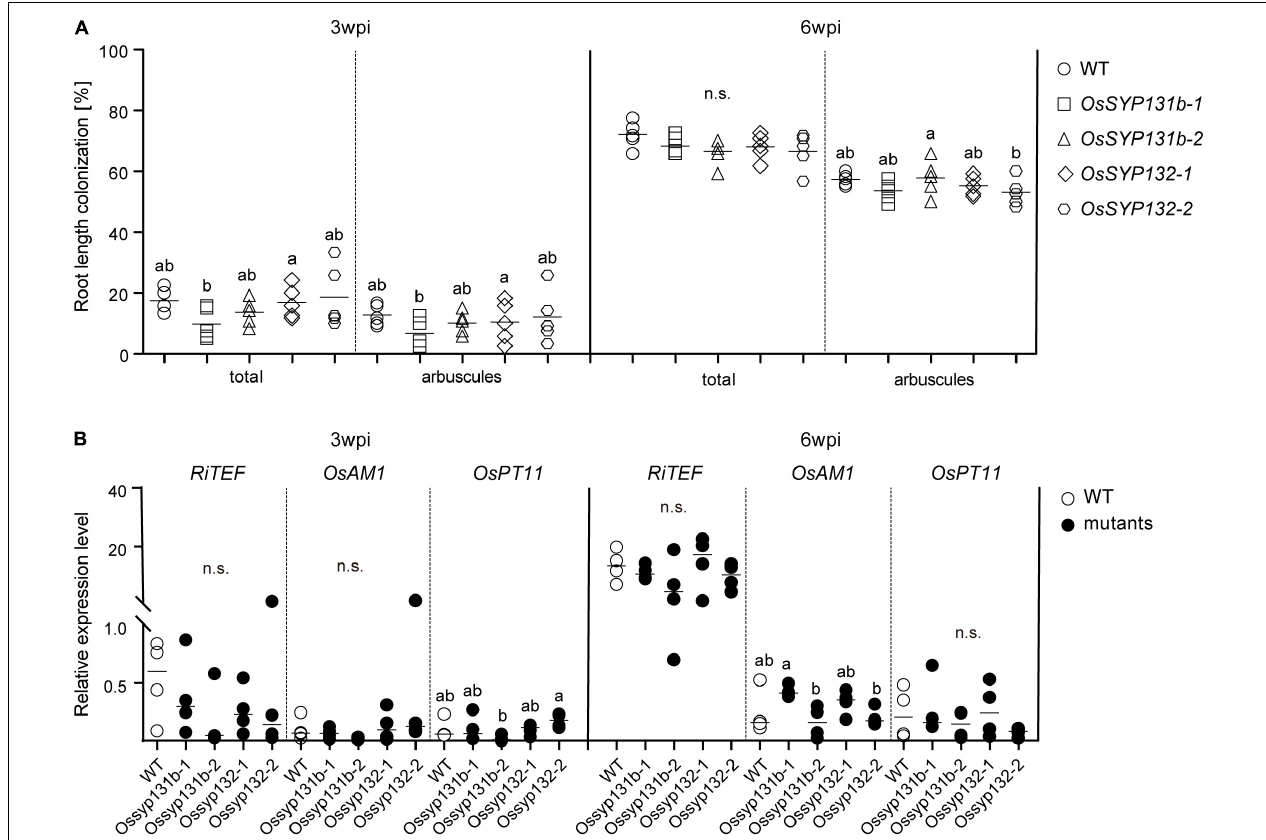
FIGURE 4 | AM symbiosis was normal in the Ossyp131b and Ossyp132 single mutants. (A) The total root length colonization rates and arbuscule abundance (%) of WT rice and Ossyp131b , Ossyp132 mutants at 3- and 6-wpi by R. irregularis were determined by the gridline intersect method. Data were individual values from five biological replicates and the horizontal line showed the mean value. Different letters indicate statistical differences between genotypes evaluated by the Tukey’s honest significance test (all pairs between WT and mutants, P > 0.05, n.s., no significance). (B) Transcript accumulation of OsRiTEF ( Translation Elongation Factor ), OsAM1 and OsPT11 ( Phosphate transporter 11 ) were measured by qRT-PCR in WT roots and mutants in the presence of R. irregularis at 3- and 6-wpi. The housekeeping gene, OsUBI1 , was used for normalization. Data were individual values from four biological replicates and the horizontal line showed the mean value. Different letters indicate statistical differences evaluated by the Tukey’s test, too (all pairs between WT and mutants, P > 0.05, n.s., no significance). This is a representative experiment that was repeated three